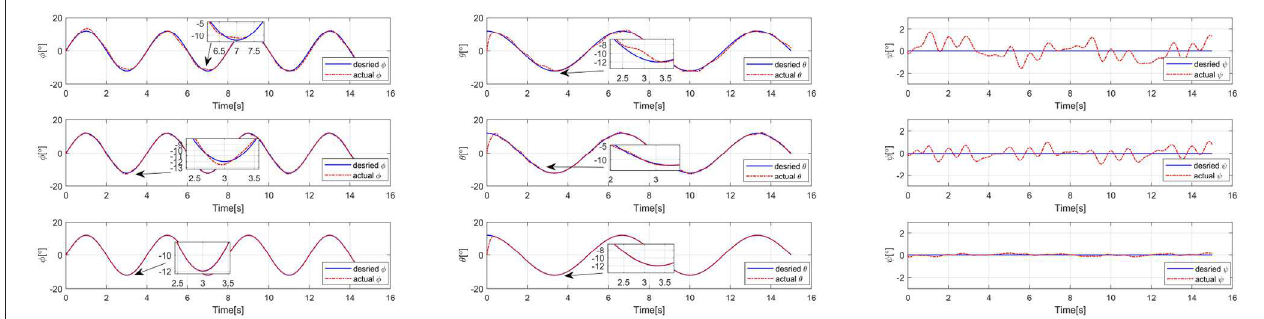
FIGURE 6 | Simulation results of roll, pitch, and yaw angle-tracking with unknown external torque disturbance. Without observer (Up), traditional ESO (Middle), and STESO (Down).